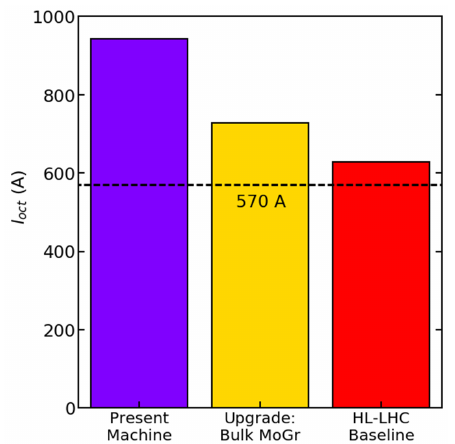
Figure 3. Octupole current needed to stabilize the BCMS beam under different collimator cases: present CFC primary and secondary collimators (violet bar), all the secondary collimators in IR7 upgraded to MoGr (yellow bar), and HL-LHC baseline with 9 out of 11 Mo-coated secondary collimators in IR7 (red bar). In all the upgrade scenarios two IR7 primary collimators are upgraded to MoGr jaws. The dashed line shows the maximum achievable octupole current of 570 A. The estimates assume a single-beam stability threshold with a factor 2 safety margin to account for additional destabilizing effects ranging from the imperfections of the impedance model and the optics to hardware noise. More details on the estimates can be found in